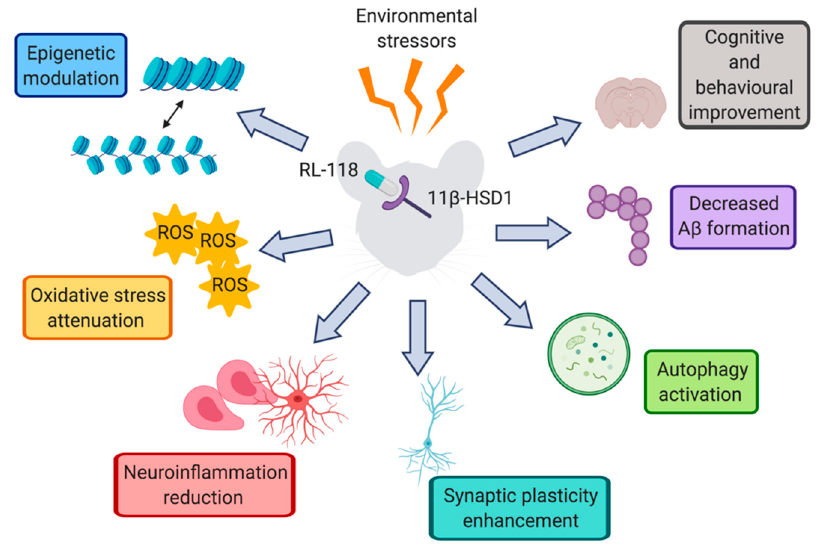
Figure 9. Representative scheme of the molecular pathways altered after RL-118 treatment in SAMP8 mice under chronic mild stress. Authors should discuss the results and how they can be interpreted from the perspective of previous studies and of the working hypotheses. The findings and their implications should be discussed in the broadest context possible. Future research directions may also be highlighted.